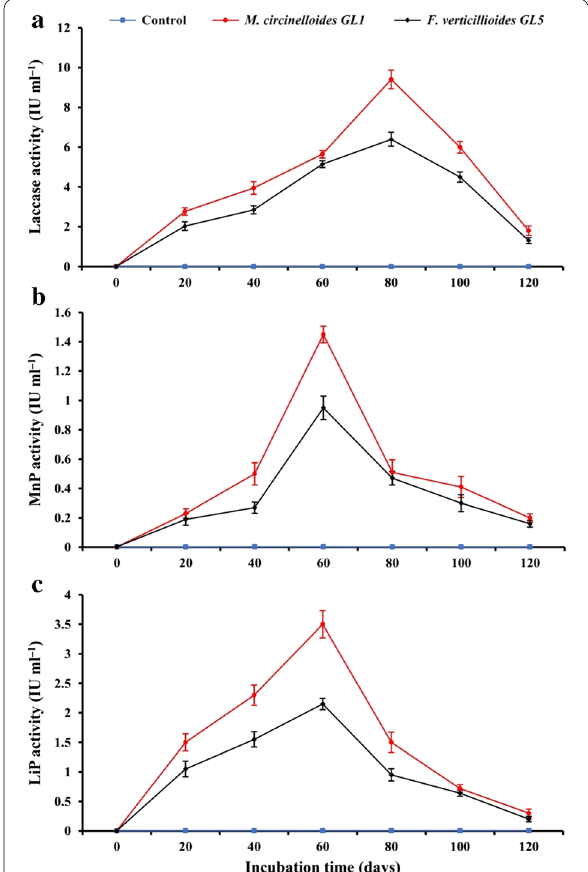
Fig. 1 Changes in ligninolytic enzyme activity of areca husk treated with ligninolytic fungi during solid-state fermentation in different time intervals. a laccase, b MnP and c LiP